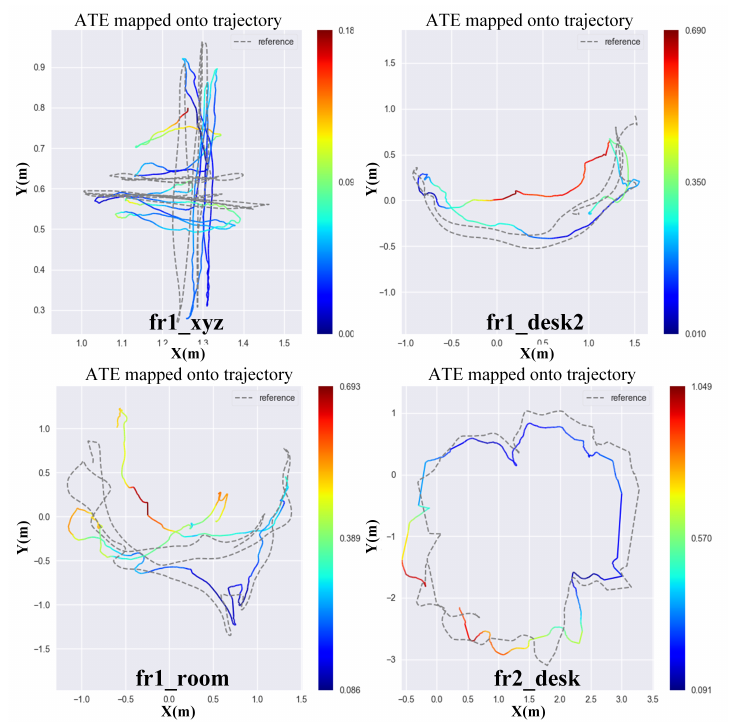
Figure 8. Ground truth vs. our trajectory for all kinds of datasets. The darkness of color reflects the value of ATE. The darker the color is, the smaller the value of